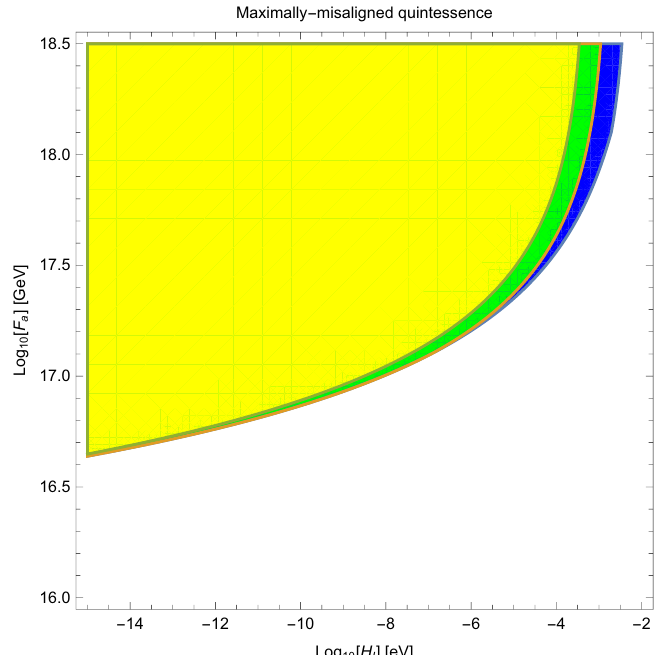
Figure 4 . Parameter space allowed for (single axion) maximally-misaligned quintessence. The lower is H , the lower can be the axion decay constant F . The axion mass changes accordingly so I a that the relation ( m ) 1 / 2 = 2 . 5 meV is maintained. The blue region satisfies ∆ θ ( z = 0) . 0 . 5 , a F a the green satisfies ∆ θ ( z = 0) . 0 . 05 and the yellow ∆ θ ( z = 0) . 0 . 005 . This traversed field distance fixes the dark energy equation of state today, w (0) (see eq. (4.16)). All the regions satisfy Planck 2018 bound, w . − 0 . 95